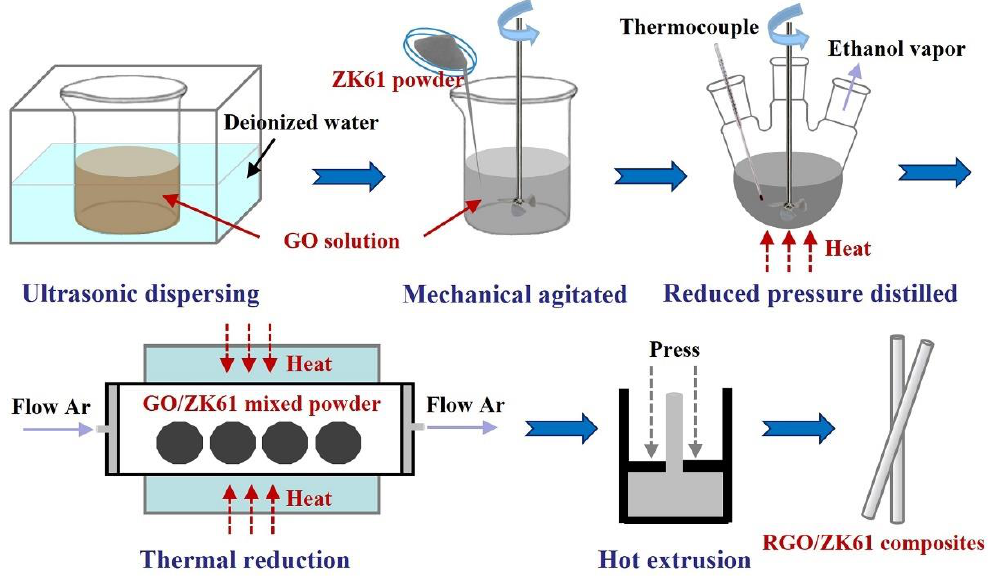
Figure 1. Schematic diagram of the fabrication of RGO/ZK61 composites.